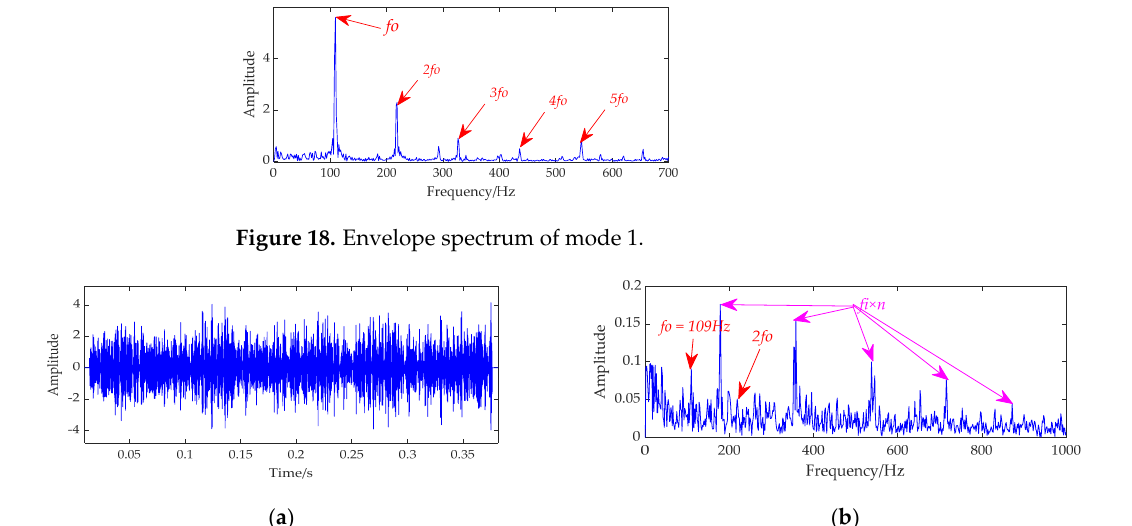
Figure 19. Feature extraction of inner ring in composite fault signal. ( a ) Time-domain waveform using CLNGO-MNAD. ( b ) Envelope spectrum using CLNGO-MNAD.